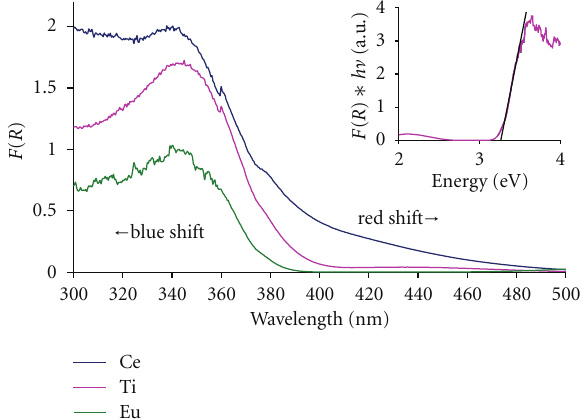
Figure 2: The UV-Vis spectra of selected RE electrodes (main plot) and graphical presentation of the bandgap determination for Ti electrode (insert).